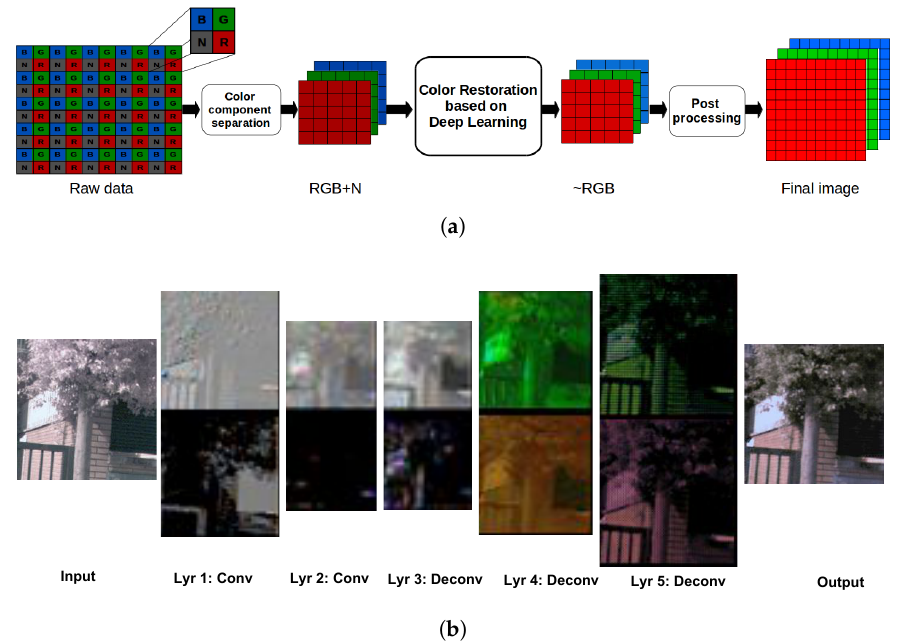
Figure 3. ( a ) Color restoration pipeline: the raw data corresponds to the information provided by the Single Sensor Camera (SSC); RGB+N represents the three channels affected by the NIR information which is referred to in the current work as X ; ∼ RGB is the restored color image, ˆ Y ; the final image is the result of the post-processing stage detailed in Section 3. ( b ) Visualization of convolutional and deconvolutional layers in ENDENet. Conv and Deconv refer to the convolutional and deconvolutional layers (Lyr: